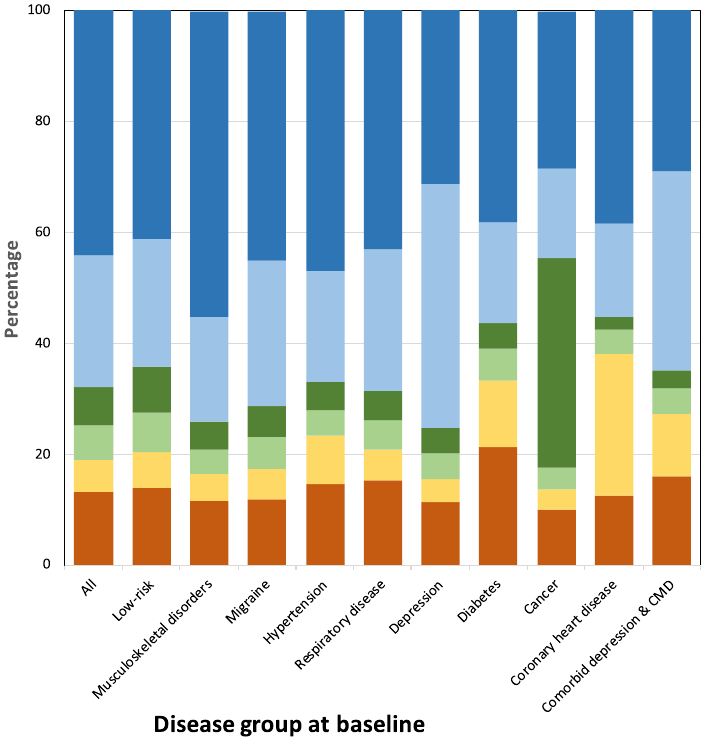
Figure 2. Causes of work disability at follow-up in all participants and those with prevalent